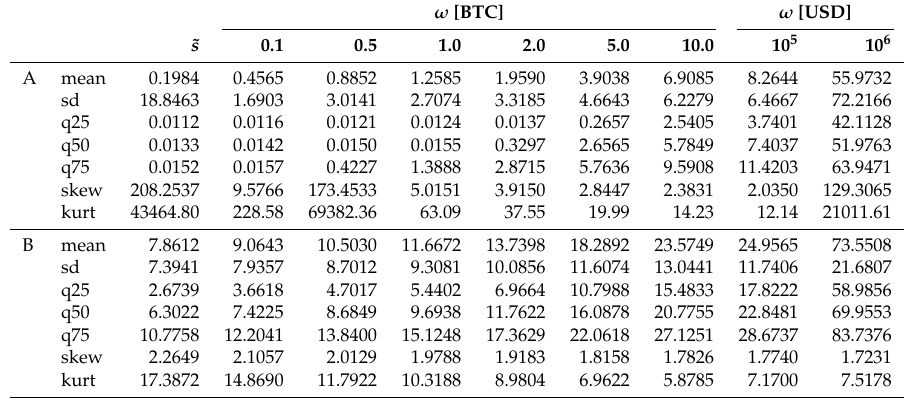
Table A3. Descriptive statistics of liquidity cost measures for the Coinbase (panel A) and the Bitstamp BTC/USD market (panel B). We list descriptive statistics of the bid-ask spread ˜ s and volume-weighted average price spreads ˜ vs for different order volumes ω